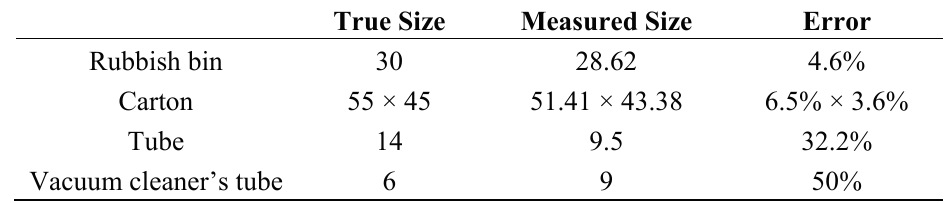
Table 1. The summary of the accuracy of map variation detection on different object (unit: